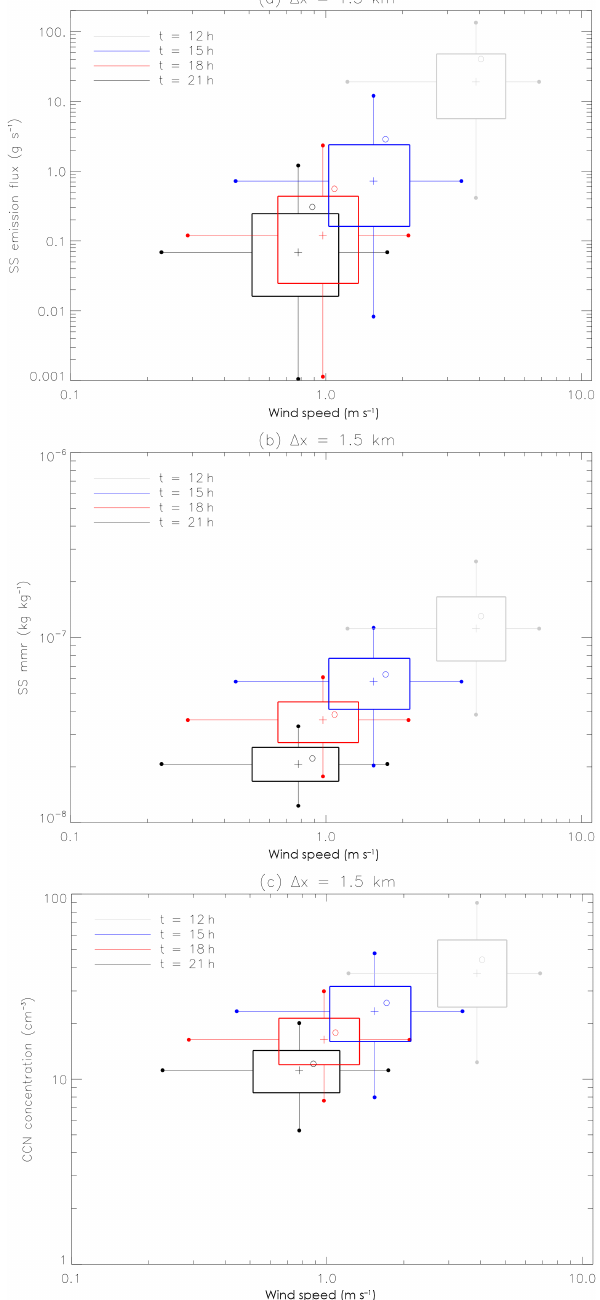
Figure 8. 2D distribution of the surface sea-salt emission flux (a) , sea-salt mass mixing ratio (MMR) (b) and CCN concentration (c) as a function of the surface horizontal wind for four different inte- gration times ( t = 12, 15, 18 or 21h). The hinges of the box plots represent the 25th and 75th percentiles and the ends of the whiskers (full circles) represent the 5th and 95th percentiles. The plus sym- bols represent the median values. The empty circles show the mean values over the